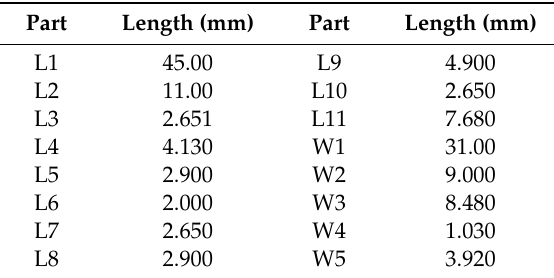
Figure 1. Circular antenna structure. Table 1. Antenna dimensions.